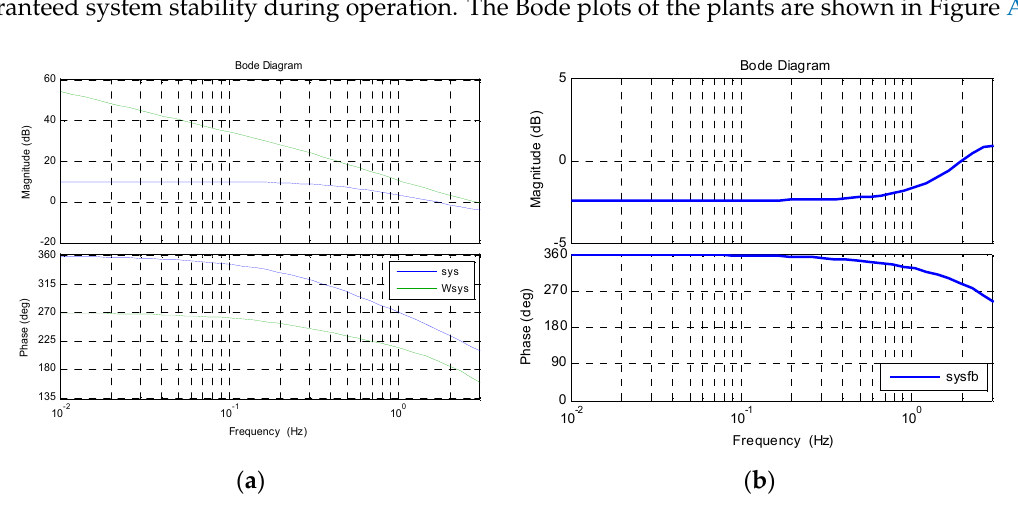
Figure A3. Bode plots for control design. (a) Open-loop Bode plots for robust control design; (b) Closed-loop Bode plots for pre-compensator design.